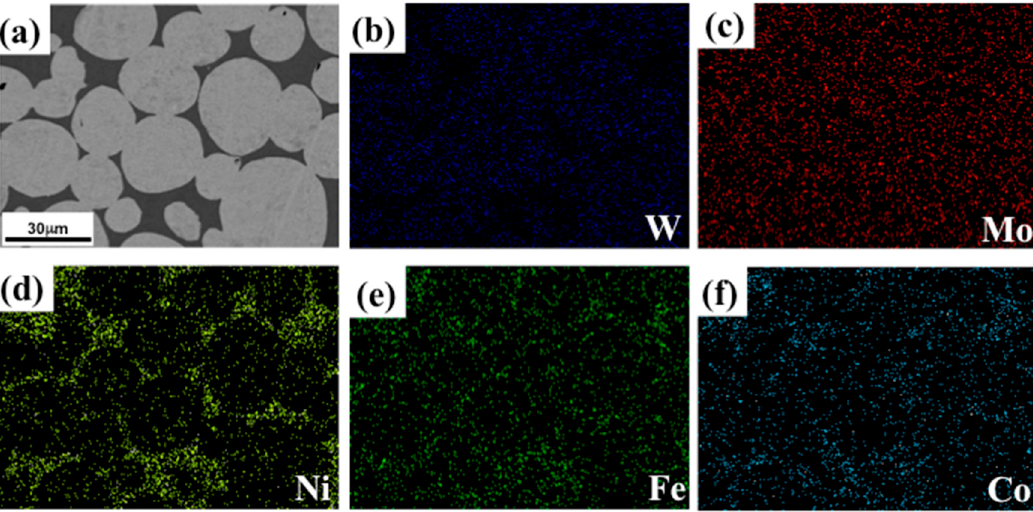
Figure 6. The EDS mapping of the W3Mo model alloy; ( a ) SEM image, ( b ) W map, ( c ) Mo map, ( d ) Ni map, ( e ) Fe map, and ( f ) Co map.